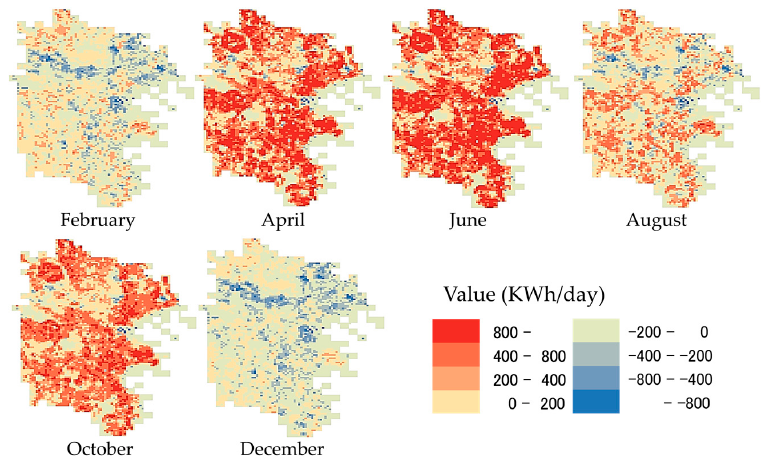
Figure 2. Estimated storage availability for six months in each 250-m grid.